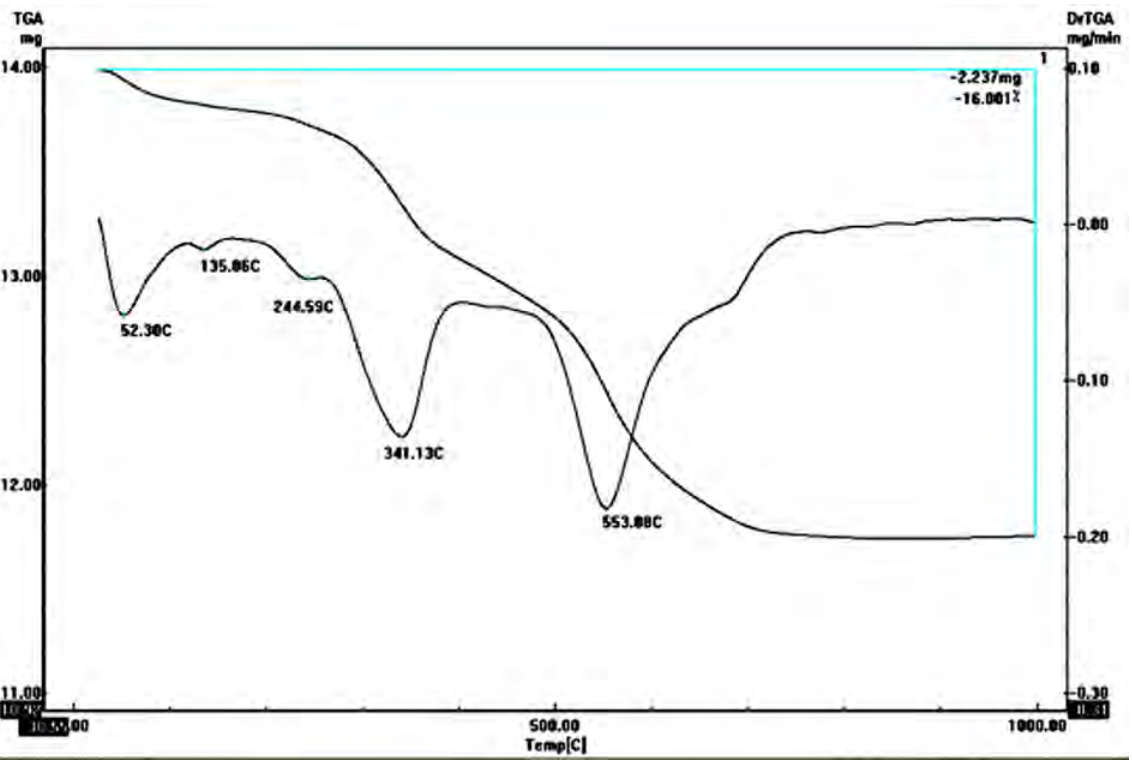
Figure 4. Thermogravimetric analysis of a brick containing 1% PS and 3%